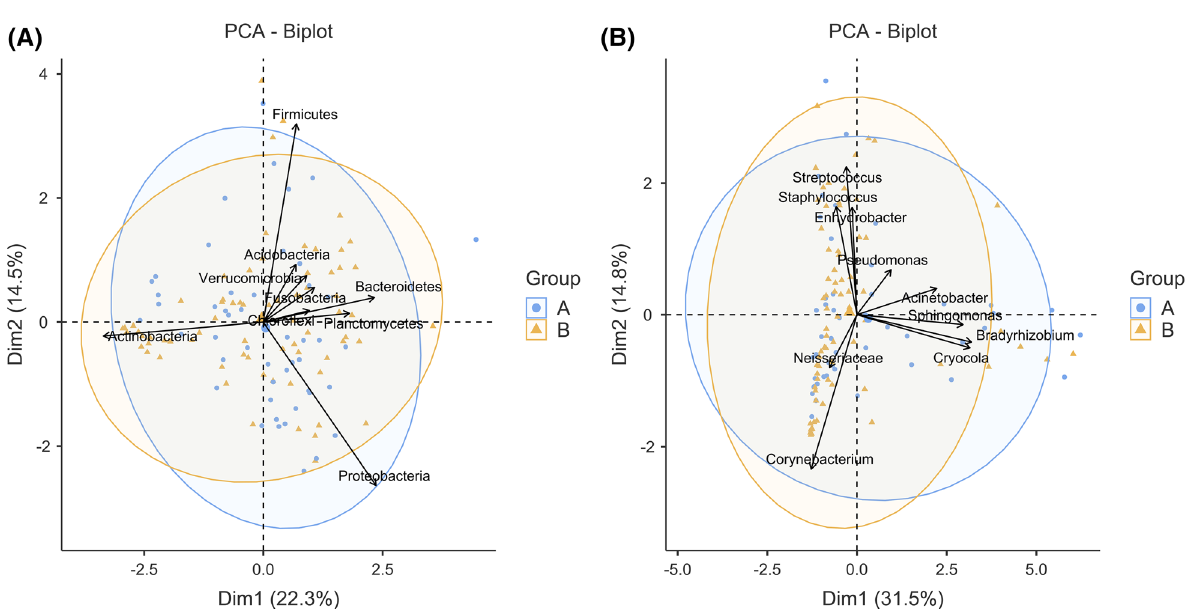
Figure 4. Principle component analysis (PCA) bi-plot showing the beta-diversity of the two groups according to phyla ( A ) and genera ( B ). The numbers on the graphs are the sample IDs of enrolled subjects. PCA principle component analysis; dim dimension. The two ellipses in each graph represent the 95% confidence